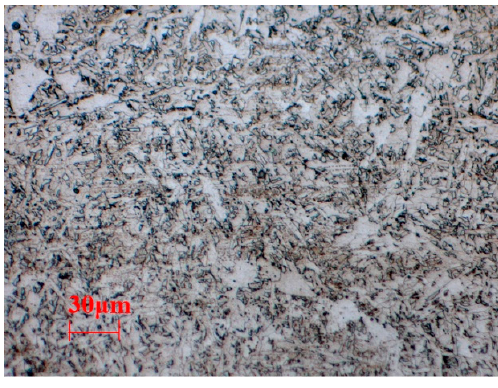
Figure 22. Initial Figure 22. Initial welding.